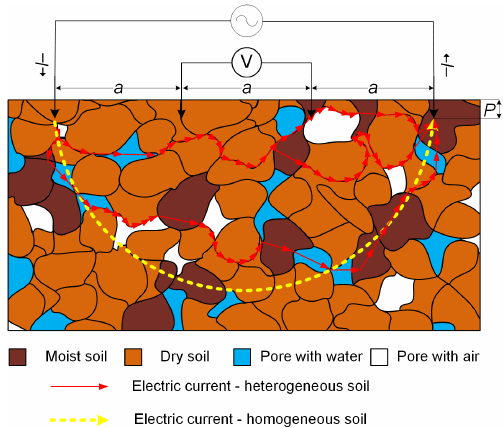
Figure 1. Simplified constitution and main current pathways in the